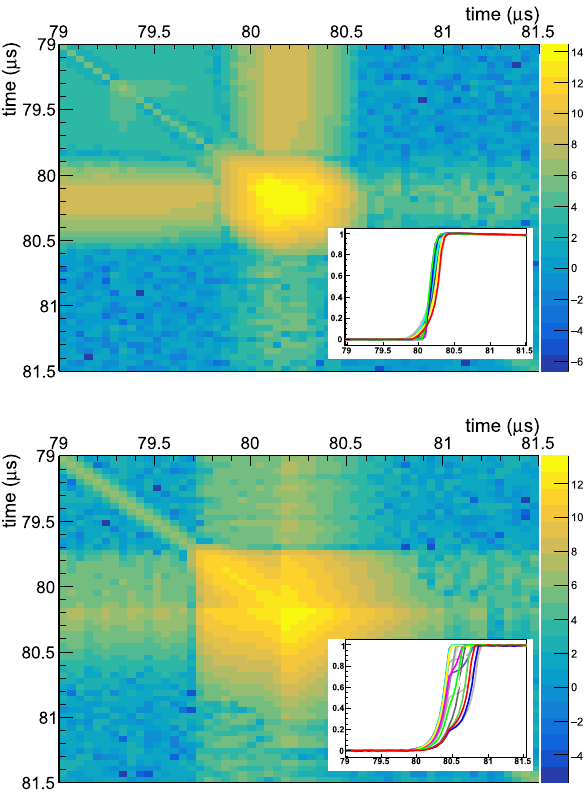
Fig. 8 The non-trivial portions of two “flat-top” constraints matrices are shown, together with a few corresponding time signals in the insets